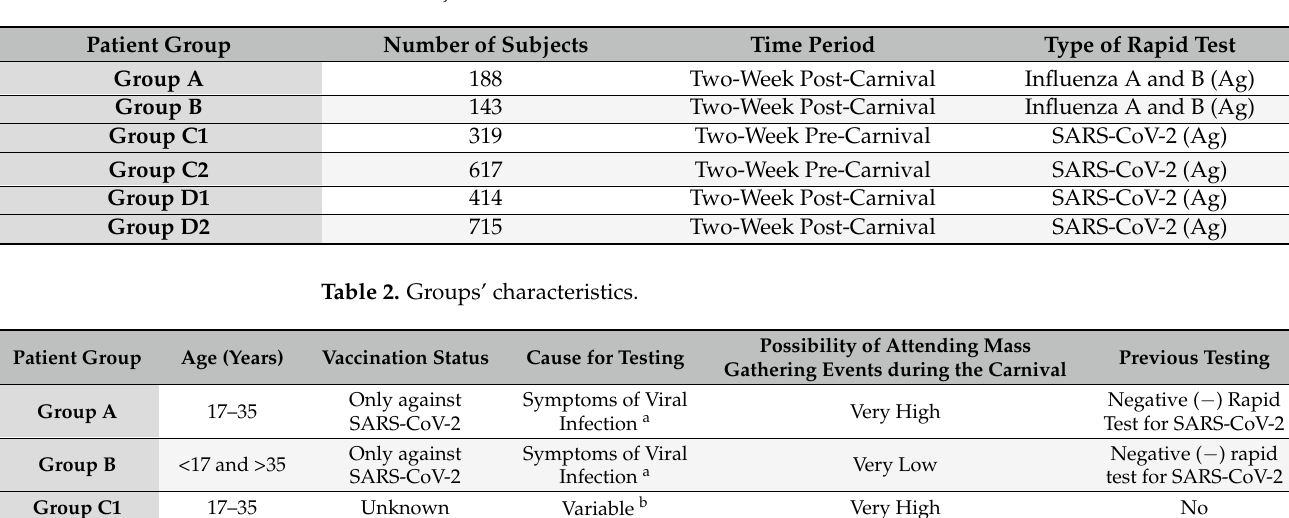
Table 1. Subject enrollment.